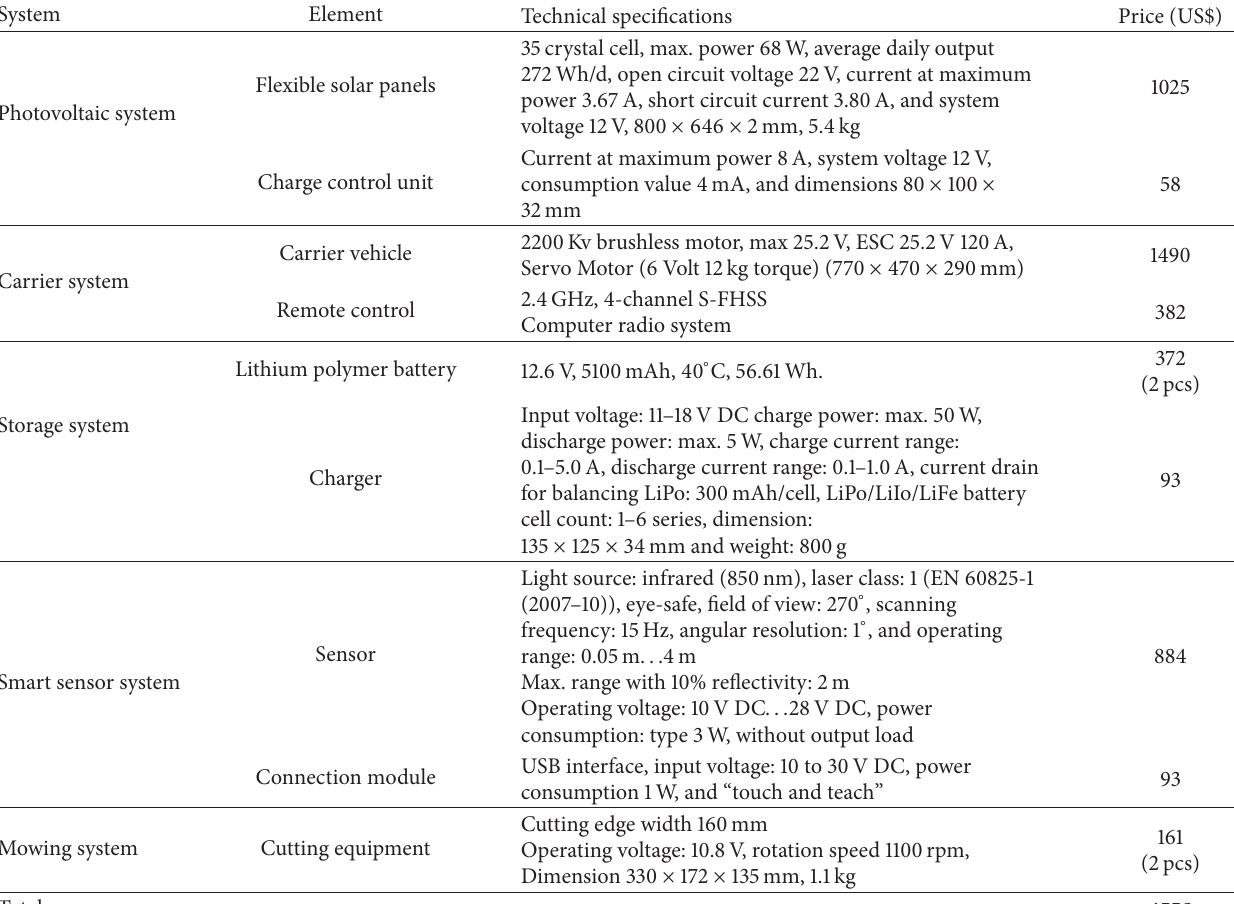
Table 1: The main components specification and characteristics of the system studied.